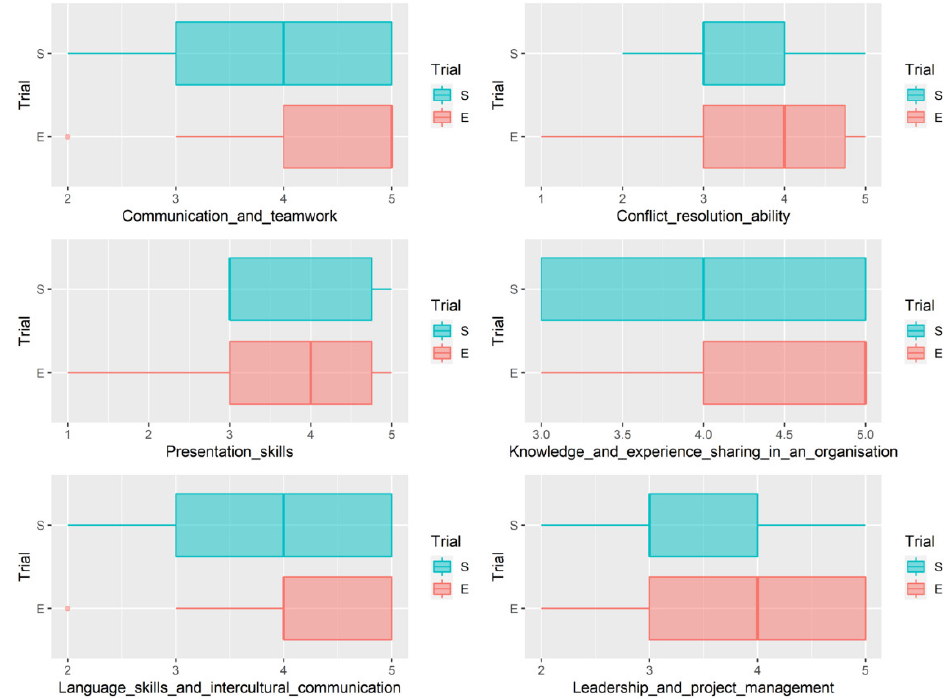
Figure 6. Assessments of social competencies in the trials (1—not important, 5—very important). Source: own elaboration.